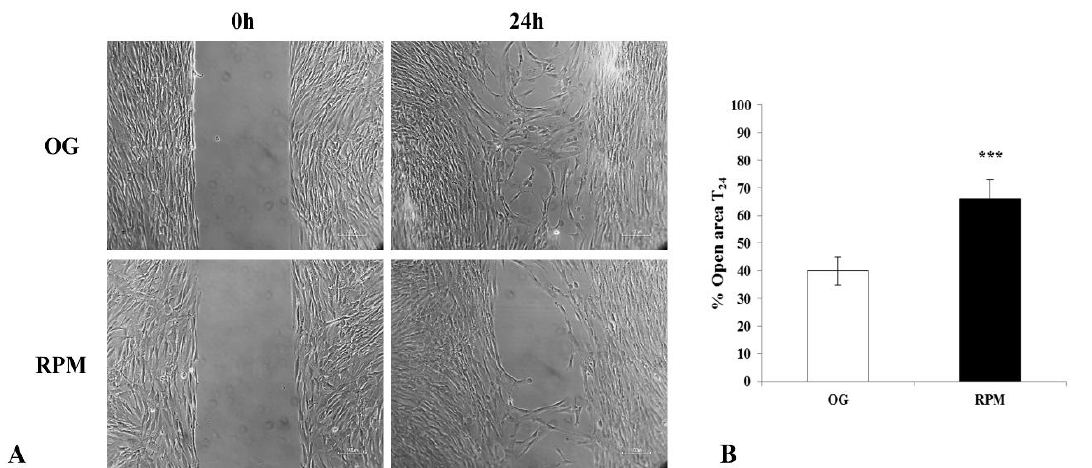
Figure 3. Effects of simulated microgravity on wound healing in human dermal fibroblasts at 24 h. ( A ) Representative images show human fibroblasts exposed or unexposed to the RPM for 24 h at 0 and 24 h. Images were obtained by optical microscopy with 100 × magnification. ( B ) Values are expressed as the percentage of open area, measured using ImageJ v 1.47 h software; the value of the open area at 0 h is 100%. Each column represents the mean value ± SD of four independent experiments with standard deviations represented by vertical bars. *** p < 0.001 RPM versus on-ground control (OG) by unpaired two-tailed t -test.